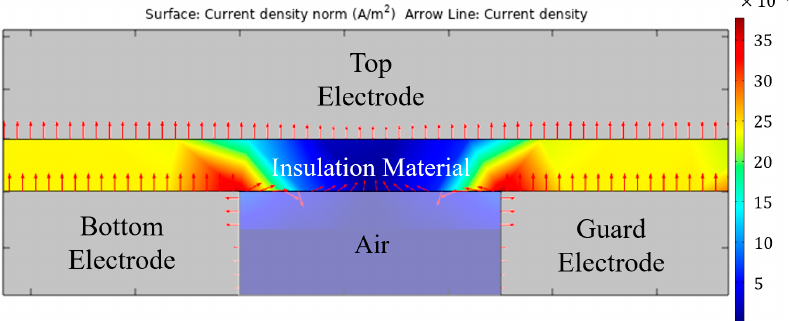
Figure 3. Volume leakage current density and flow.